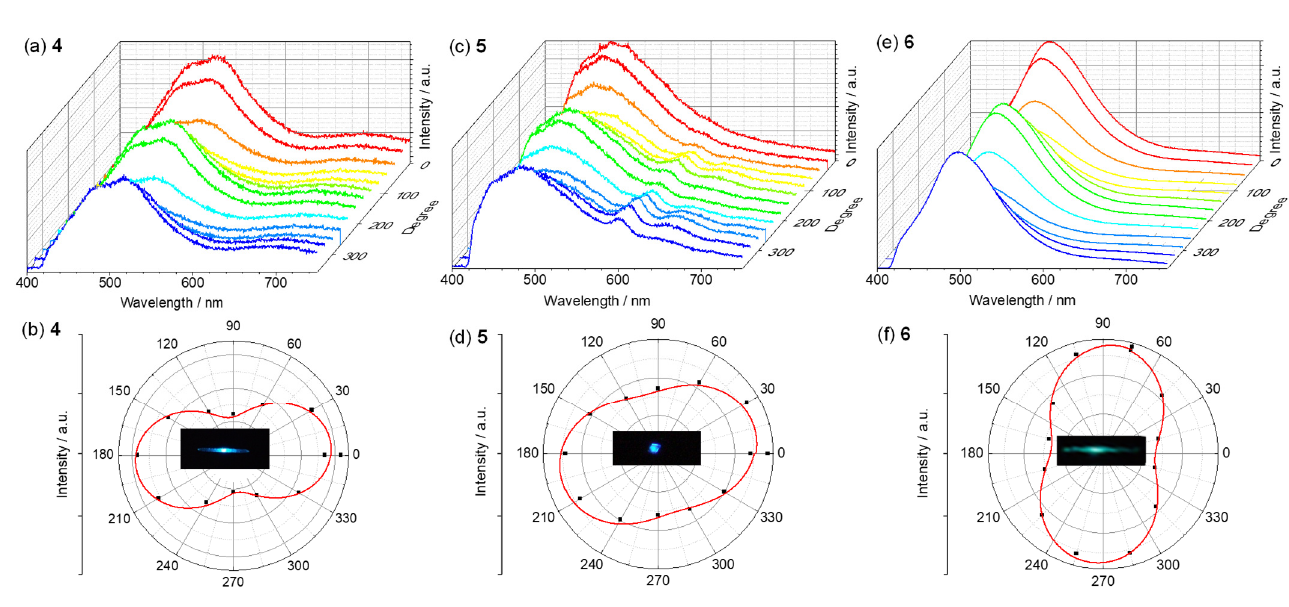
Figure 8. ( a , c , e ) Photoluminescent spectra and ( b , d , f ) corresponding polarization angle-dependent luminescence intensity distribution curves of a microcrystal of ( a , b ) 4 , ( c , d ) 5 , and ( e , f ) 6 . The red solid lines in panels ( b , d , f ) are fitted curves with the mathematical function of sin 2 . Insets are the fluorescent microscopy images of corresponding microcrystals. All microcrystals were excited with a focused semiconductor laser (CW, 405 nm).